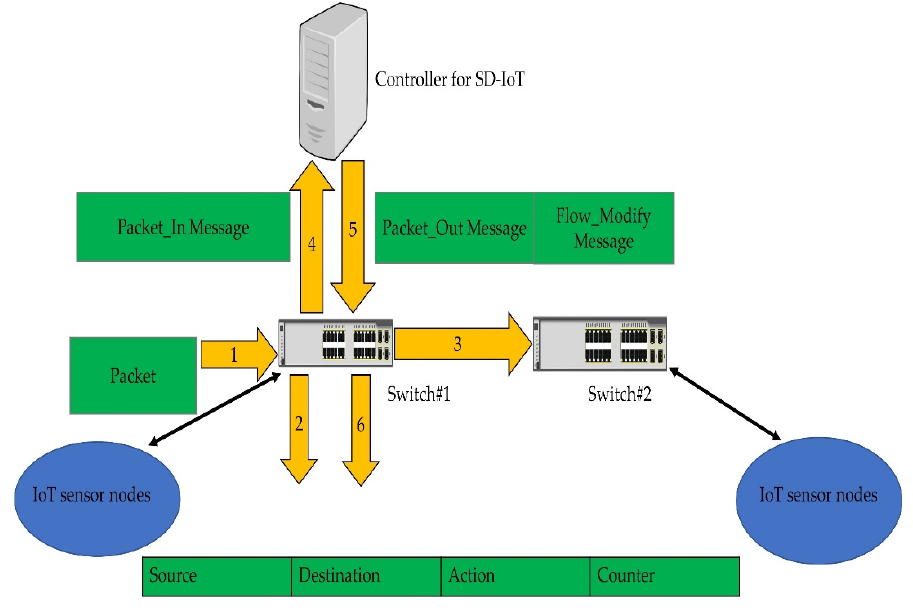
Figure 1. Sensor nodes generating traffic in SD-IoT [22].